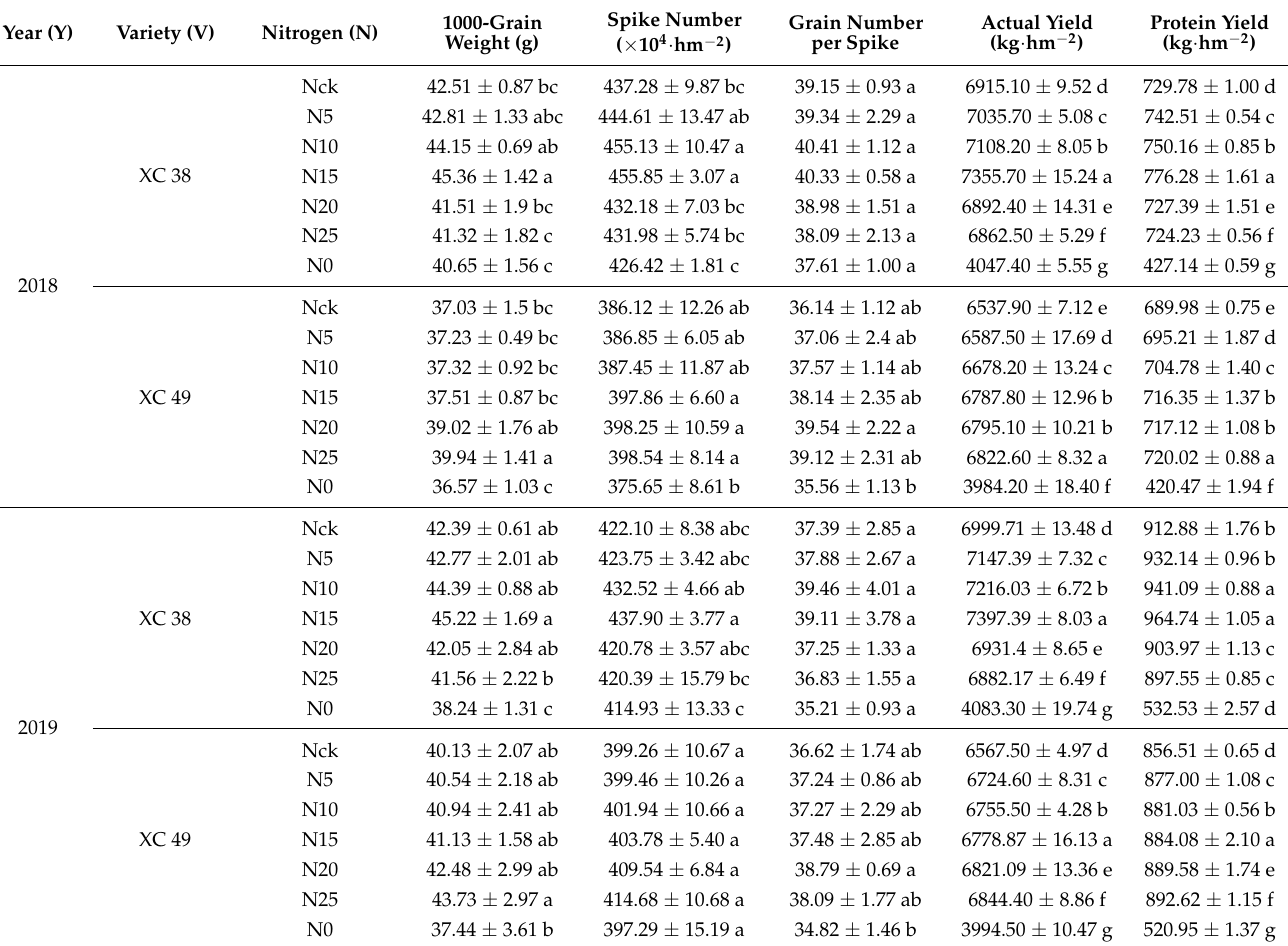
Table 4. Averages of yield of spring wheat under drip irrigation in 2018 and